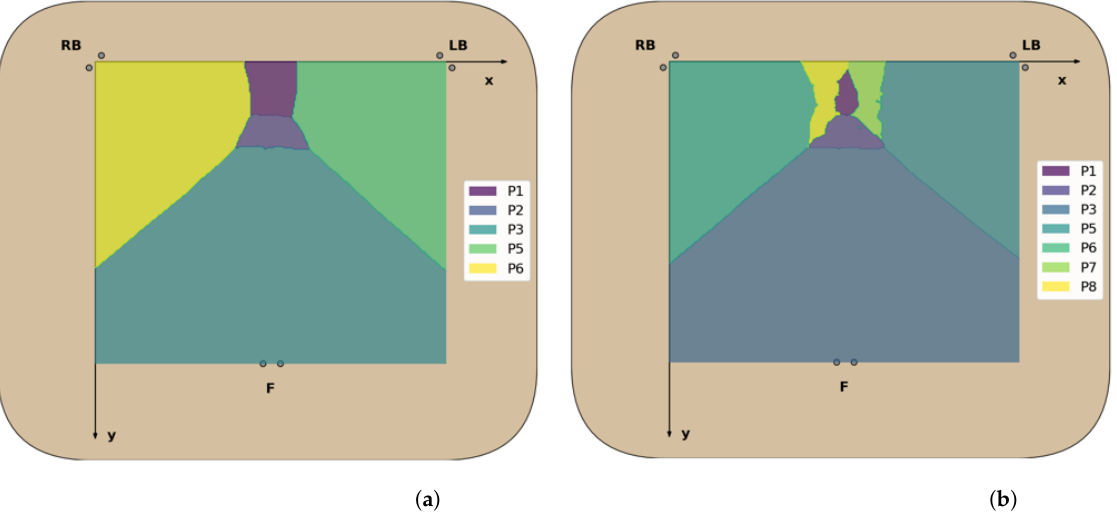
Figure 9. Decision boundaries of the best performing models: ( a ) 5-class k-NN with 1000 neighbors and ( b ) 7-class k-NN with 3000